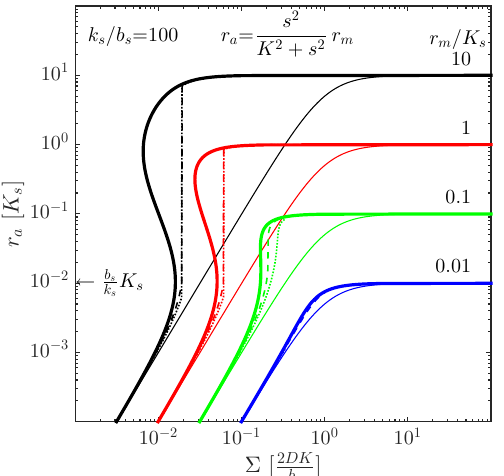
Figure 3. Intracellular concentration of activated regulator at the center of a bacterial colony as a function of the colony size. The signal molecule binding to the regulator is assumed second order and fully cooperative. Thin lines indicate the r level without feedback. Dashed a lines are the numerical solution with open boundary ( Σ = R 2 ρ ), and dotted lines are with v R 2 ρ absorbing boundary ( Σ = 1 ). Note that the ignition of the collective state always takes v 3 K ∼ b s place at r , shown on the ordinate. Adapted from [11]—published by The Royal s a k s Society of Chemistry.